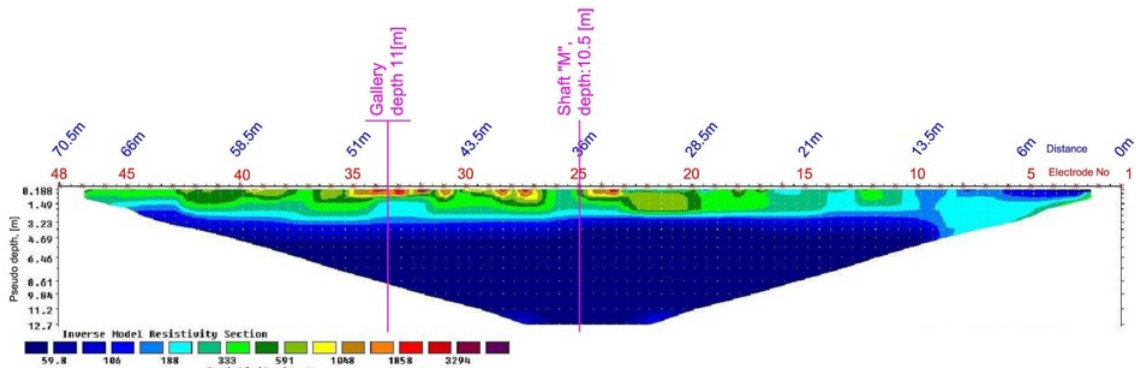
Figure 12. Location of the ERT profile against mining workings.